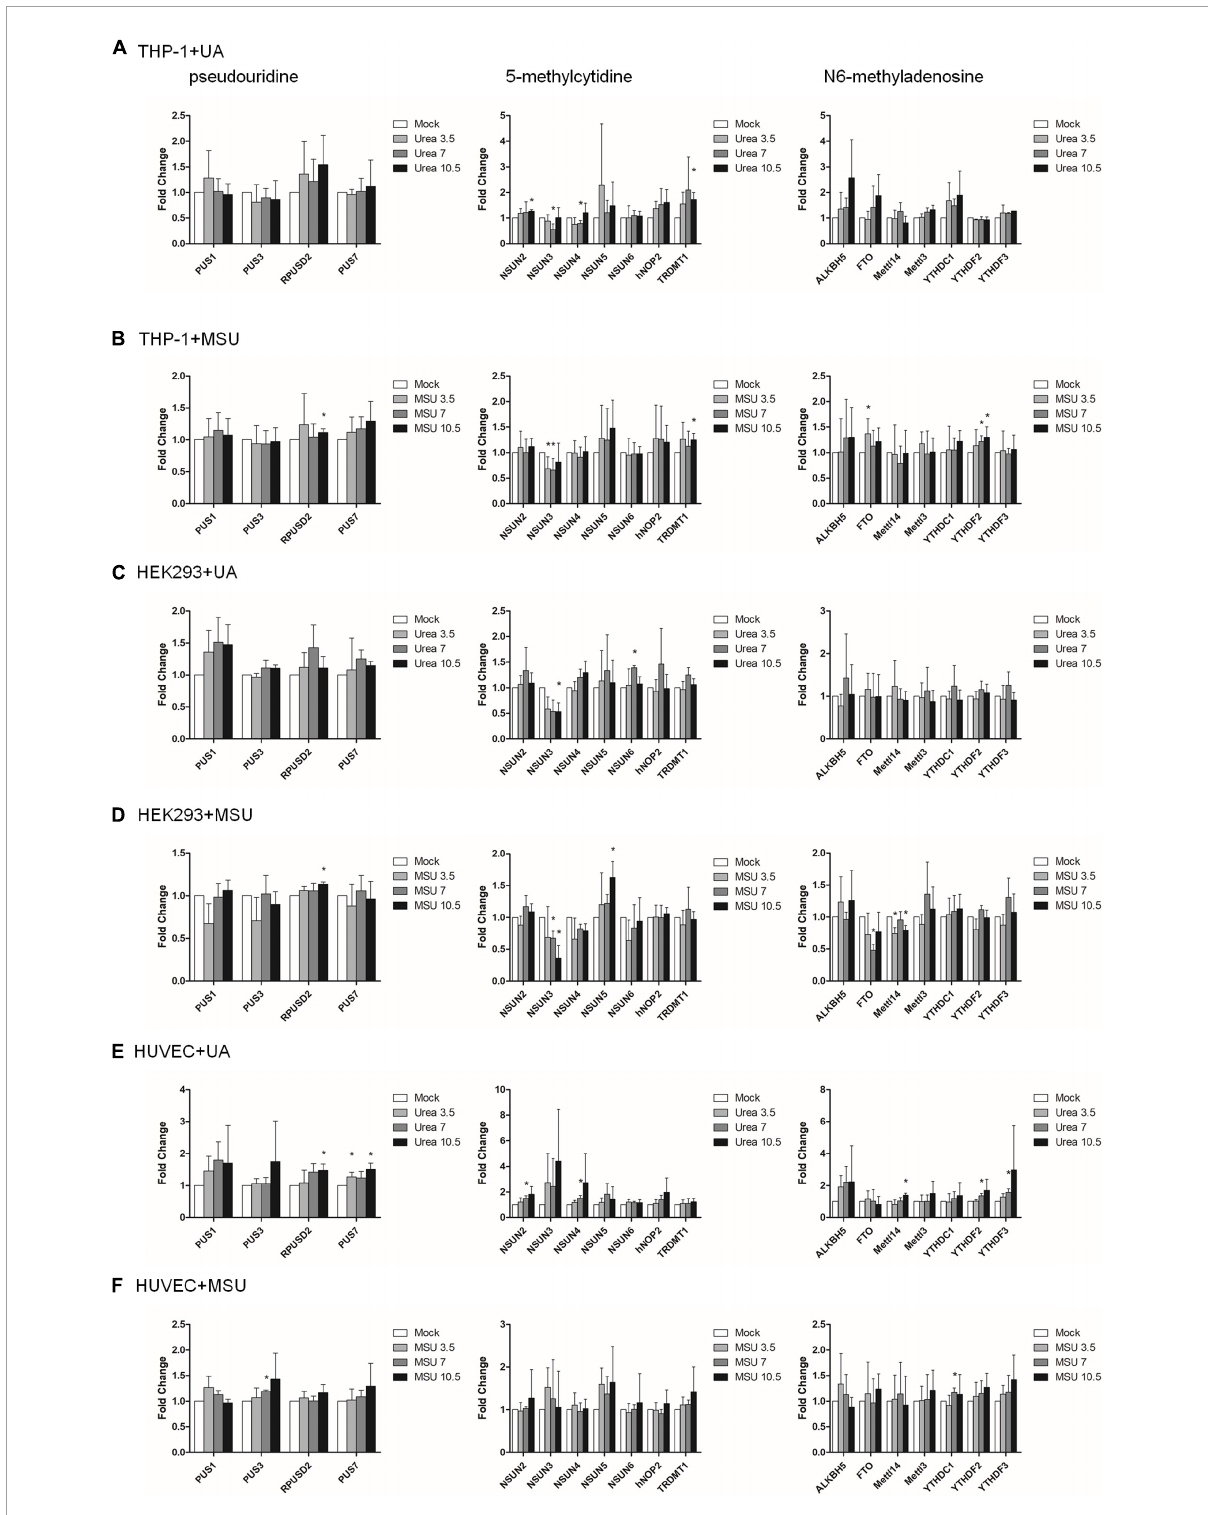
FIGURE1 RNA expressions of RNA modification enzymes were affected in MSU- or UA-treated cell lines. The expressions of enzymes involved in pseudouridine (left), 5-methylcytidine (middle), and N6-methyladenosine (right) in UA-treated THP-1 cells (A) , MSU-treated THP-1 cells (B) , UA-treated HEK293 cells (C) , MSU-treated HEK293 cells (D) , UA-treated HUVEC cells (E) , and MSU-treated HUVEC cells (F) were quantitated through real-time PCR. Error bars represent standard deviation. The results of three independent experiments were averaged to obtain the final results. * P < 0.05 by Student’s t -test, compared with mock